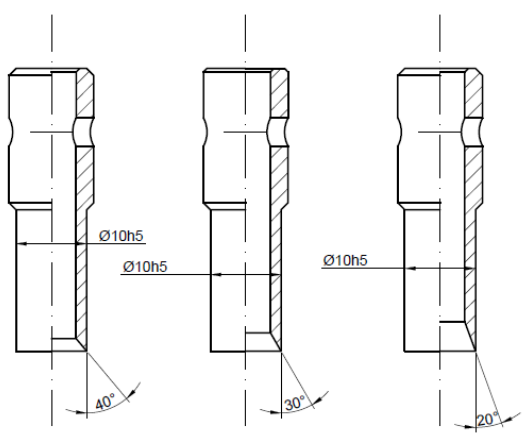
Figure 6. First series of tested tools—piercing punches with the cutting edge pointing towards the inside with a constant diameter and variable angle of the blade.